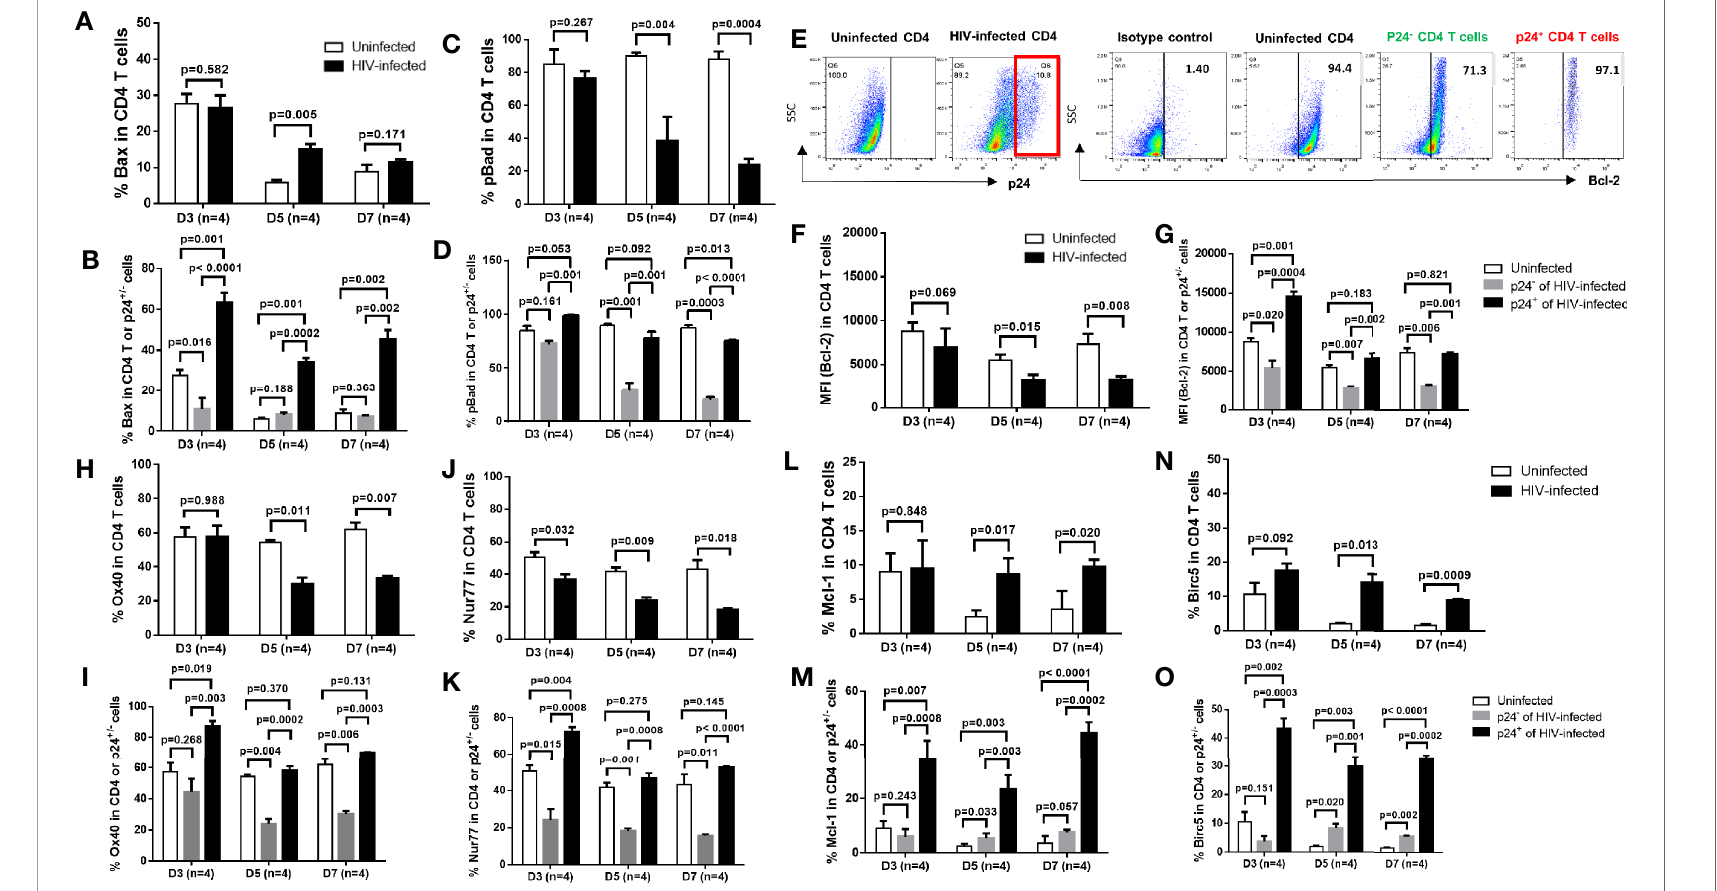
FIGURE 2 | Expression of pro- and anti-apoptotic proteins in productively infected cells and bystander cells during HIV infection. (A, B) Summary data of Bax % in HIV-infected (p24 + - ) and bystander (p24 - ) or uninfected cells at days 3, 5, and 7, as determined by fl ow cytometry. (C, D) Summary data of pBad % in HIV-infected (p24 + ) and bystander (p24 - ) or uninfected cells at days 3, 5, and 7. (E – O) Representative dot plots and summary data of Bcl-2%, Ox40% (H, I) , Nur77% (J, K) , Mcl-1 (L, M) , and Birc5% (N, O) in HIV-infected (p24 + vs. p24 - ) and uninfected cells at days 3, 5, and